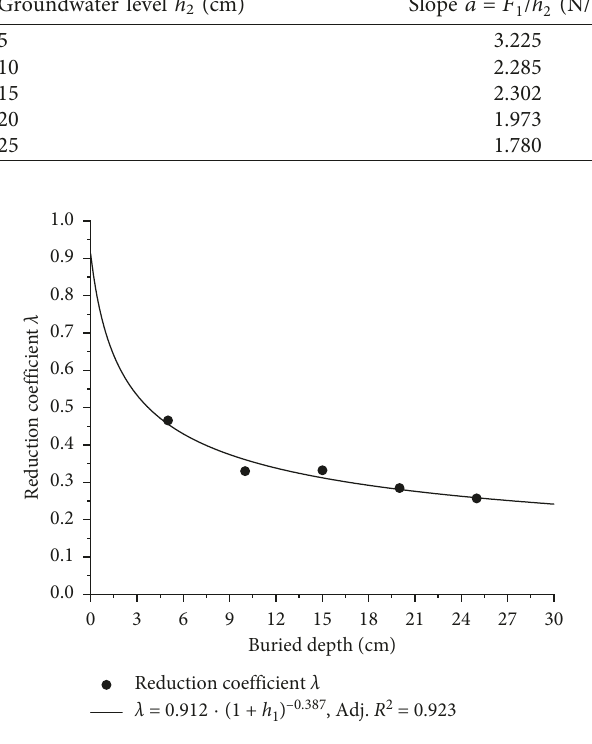
Figure 6: Function relationship between reduction coefficient λ and buried depth of the basement.